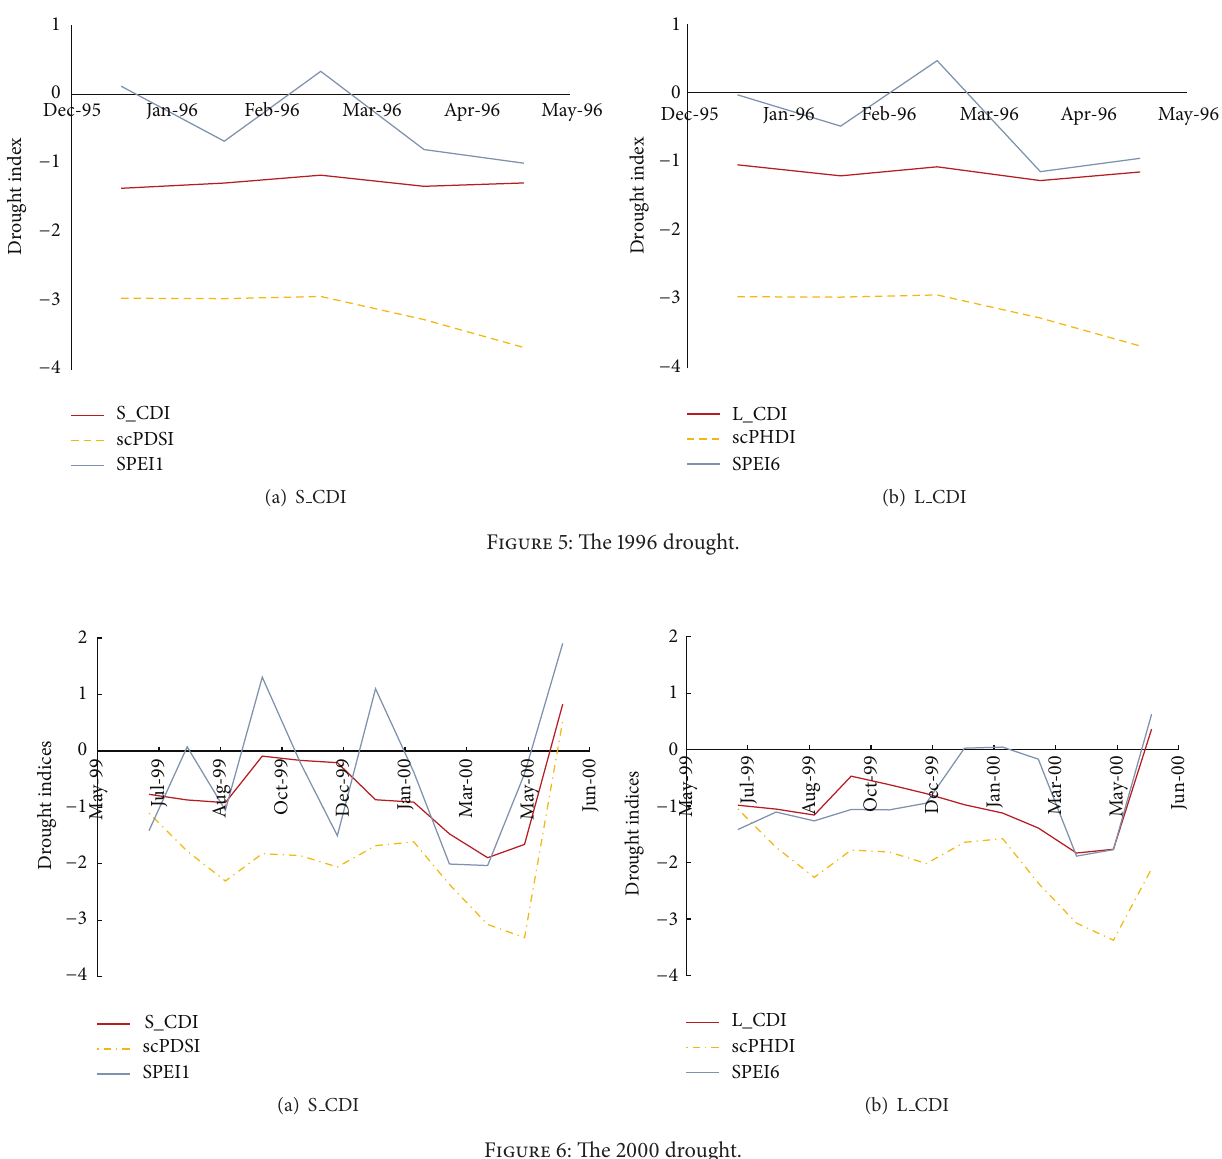
Figure 5: The 1996 drought.